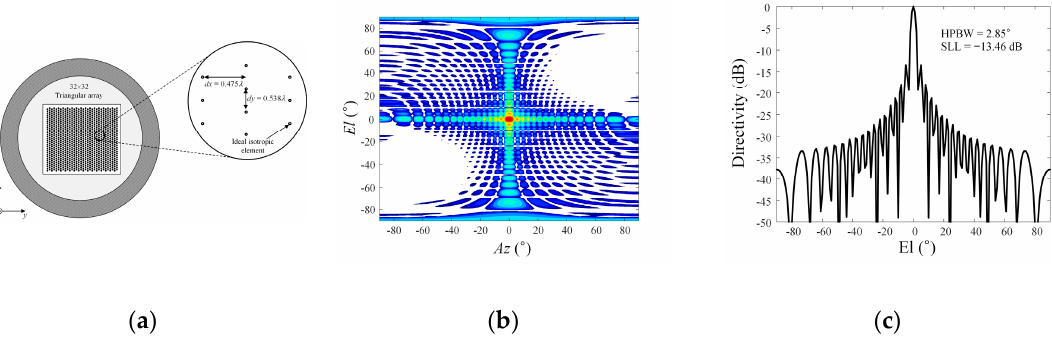
Figure 5. Array antenna characteristics of the air-to-air airborne radar: ( a ) 32 × 32 triangular array antenna configuration and array distance; ( b ) 2D array pattern in the Az / El domain; ( c ) directivity pattern at the bore-sight direction in the H-plane.